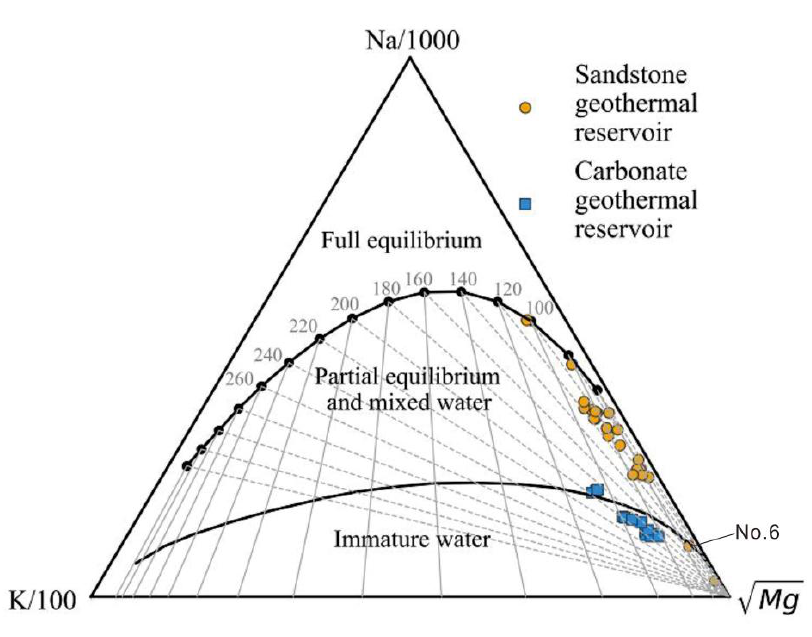
Figure 5. Diagrammatic representation of the Na-K-Mg equilibrium of a geothermal fluid.